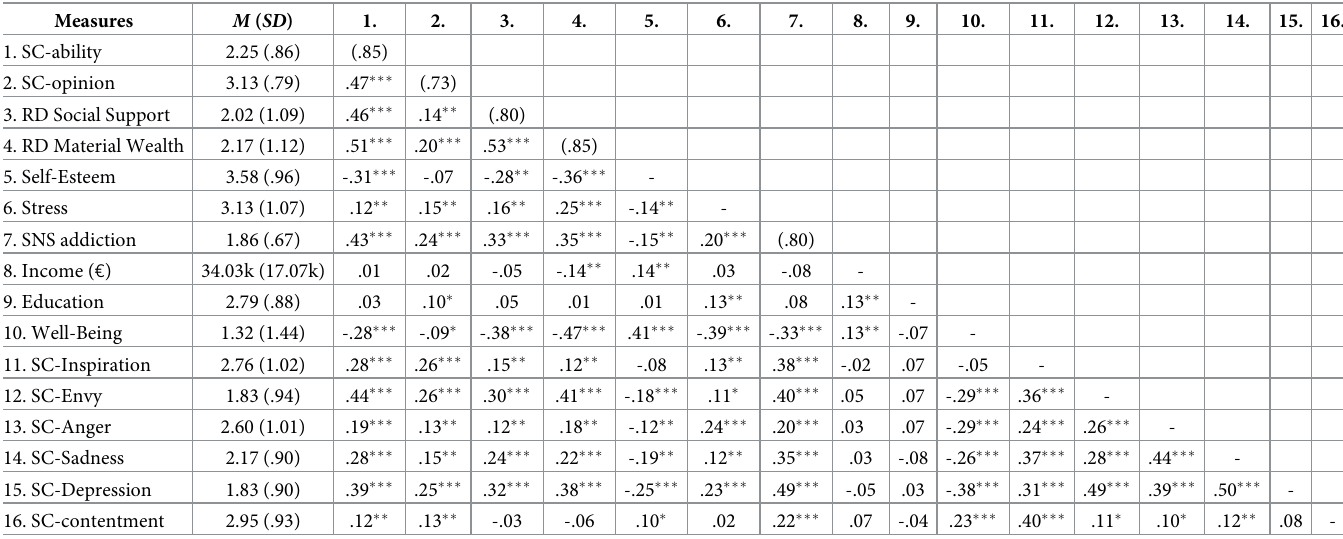
Table 6. Descriptive statistics and intercorrelations for measures in Study 2.